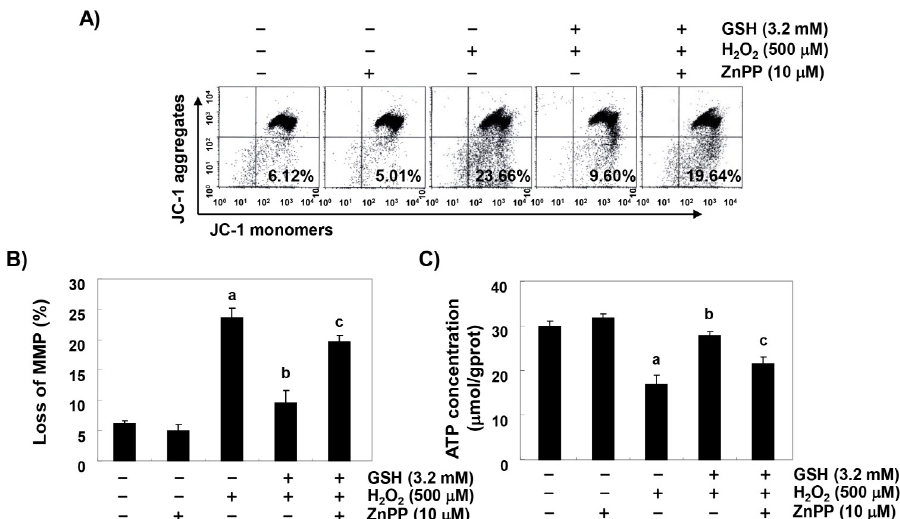
Figure 6. Attenuation of H 2 O 2 -induced mitochondrial dysfunction by glutathione in RAW 264.7 cells. Cells were pretreated with 3.2 mM glutathione or 10 μM ZnPP for 1 h and then stimulated with or without 500 μM H 2 O 2 for 24 h. ( A ) The cells were collected and incubated with 10 μM JC-1, and the MMP values were obtained with a flow cytometer. The top right quadrant indicates normal mitochondria, whereas the bottom right quadrant indicates depolarized mitochondria. ( B ) The results are the mean ± SD obtained from three independent experiments. ( C ) To monitor the ATP production using a luminometer, a commercially available kit was used. Each point represents the mean ± SD of three independent experiments ( a p < 0.05 compared with the control group; b p < 0.05 compared with the H 2 O 2 -treated group; and c p < 0.05 compared with the glutathione- and H 2 O 2 -treated group).